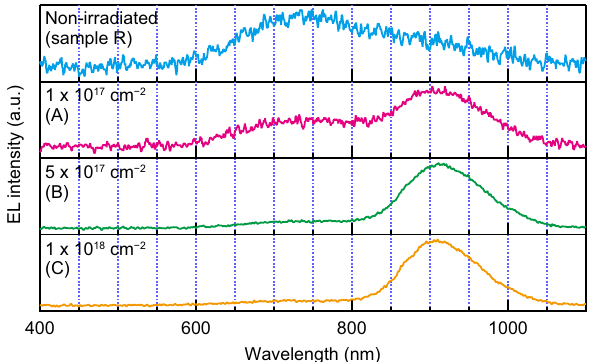
Figure 2. Electroluminescence (EL) spectra at a temperature of 300 K . All measurements were performed at a bias current of 20mA . Labels in each panel indicate the conditions of the electron irradiation dose. Note that the vertical scales are different for each panel. An emission peak around 910 nm , originating from the silicon- vacancy defects, appears with electron irradiation. This emission dominates the EL spectrum for the electron- irradiated samples (A, B, and C). The broad emission band around 720 nm is attributed to the annealing-related defects 20 . D 1 luminescence was not observed.